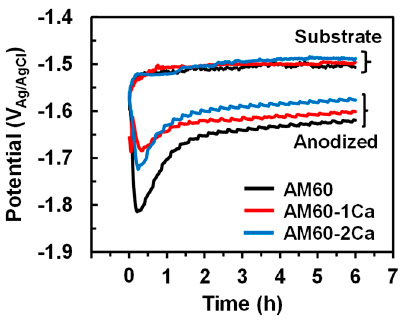
Figure 9. The open circuit potential (OCP) of substrates and anodized specimens of AM60, AM60-1Ca, and AM60-2Ca in 0.9% NaCl solution at 37 °C.